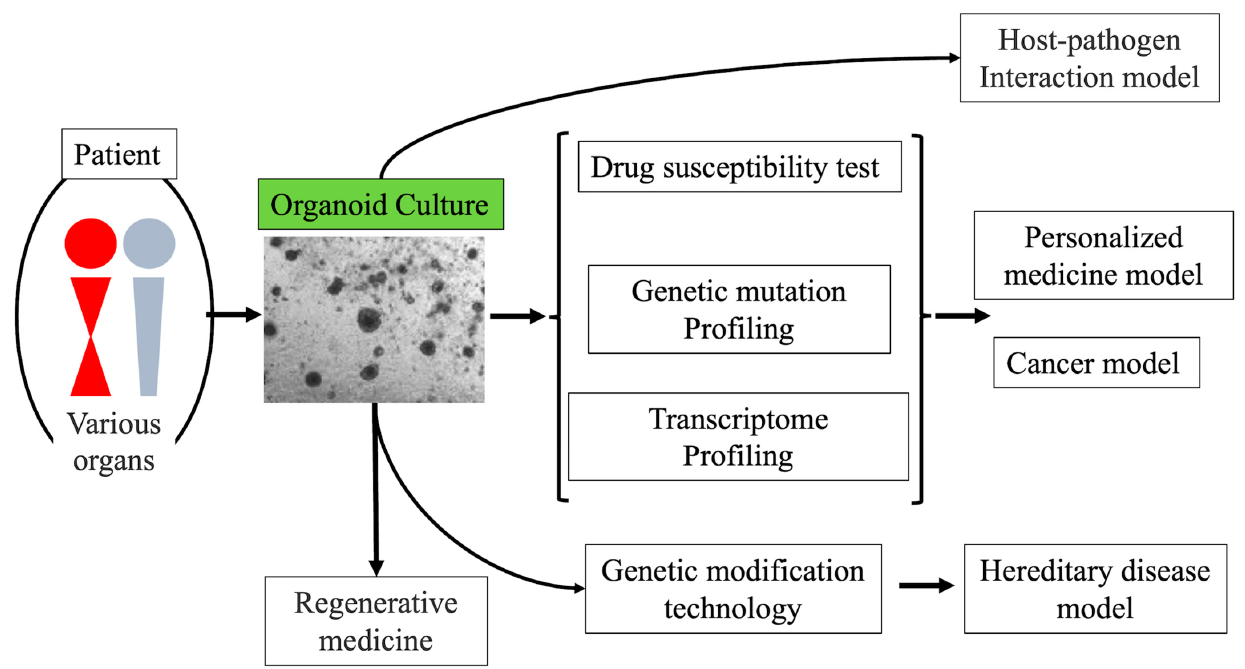
Figure 1. Applications of patient-derived organoids. Organoids have various potential applications in regenerative medicine, host-pathogen interaction models, hereditary disease models, and cancer models.